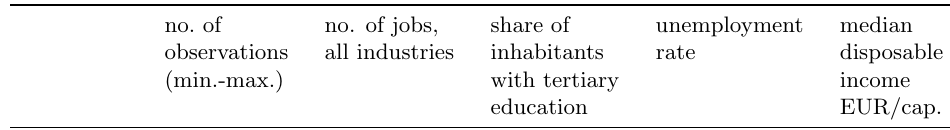
Table 4: Regression coefficients, previous Objective 2 areas (A) and previous transitional areas